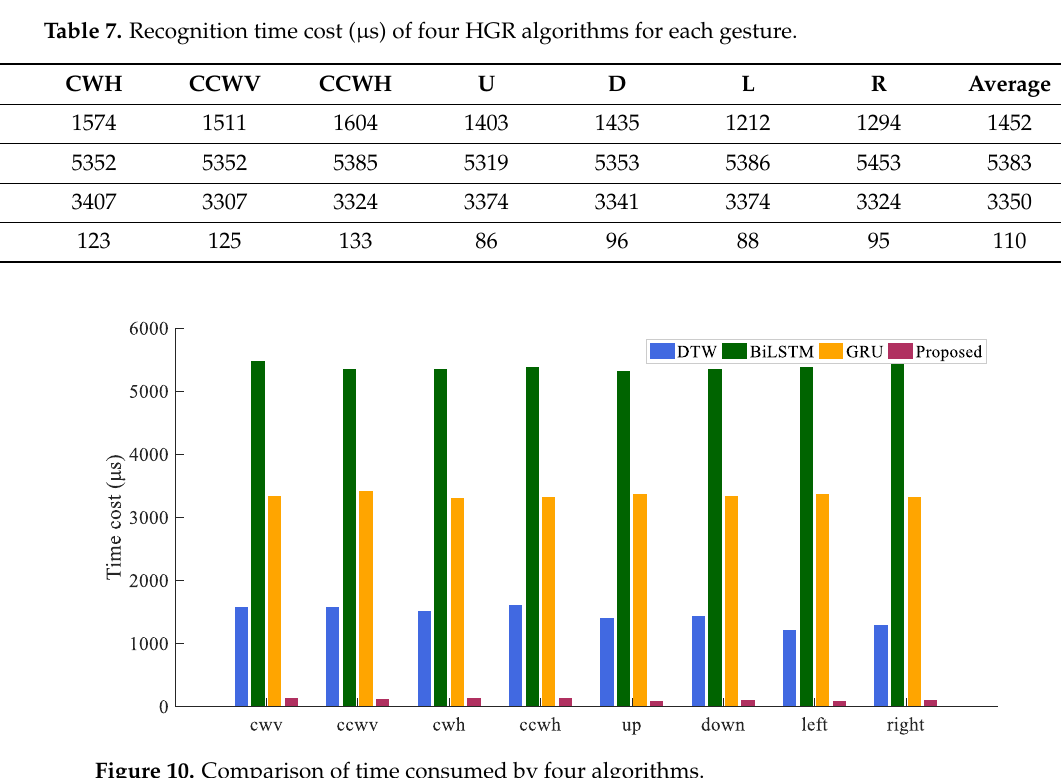
Figure 10. Comparison of time consumed by four algorithms.